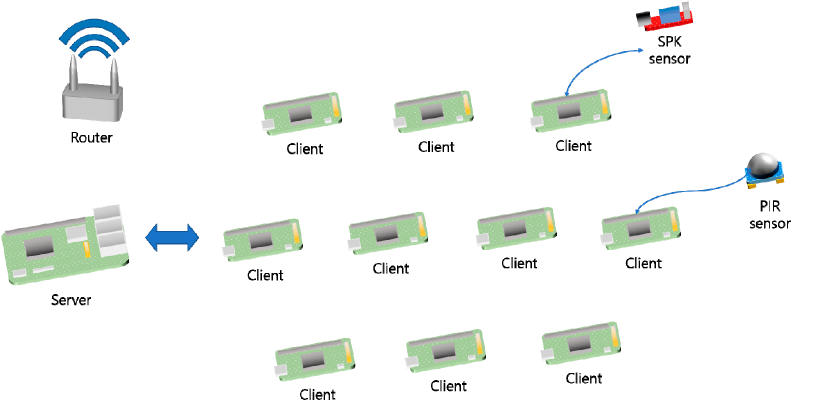
Figure 11. Hardware equipment that composes the system.